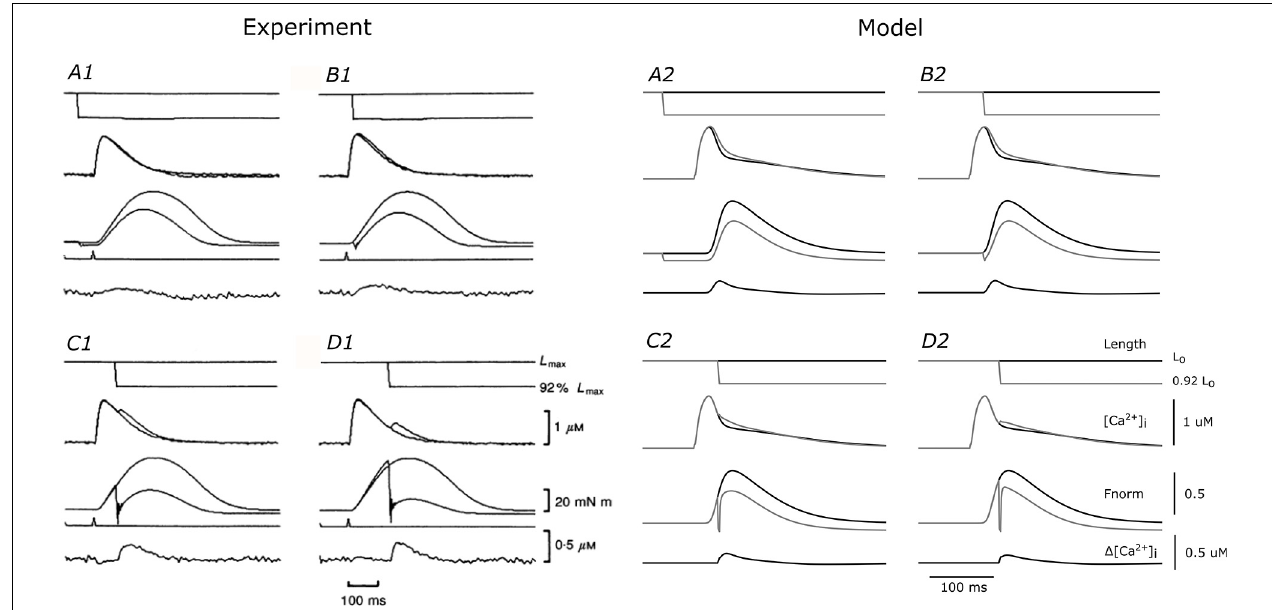
FIGURE 2 | Comparison of THR model simulations with experimental quick-release data. Experimental quick-release shortening of ferret papillary muscle by Kurihara and Komukai (1995) (left) at 30 ◦ C and equivalent simulations from the THR model (right). Each of the four panels for the experimental (A1–D1) and model (A2–D2) outputs represent different timings of the quick release. Within each panel are traces of outputs from isometric (black lines) and quick-release protocols (gray lines). From top to bottom, the traces represent muscle length, intracellular Ca 2 + concentration, total force development, and difference of Ca 2 + between the two protocols. (A1–D1 were reproduced with permission from John Wiley and